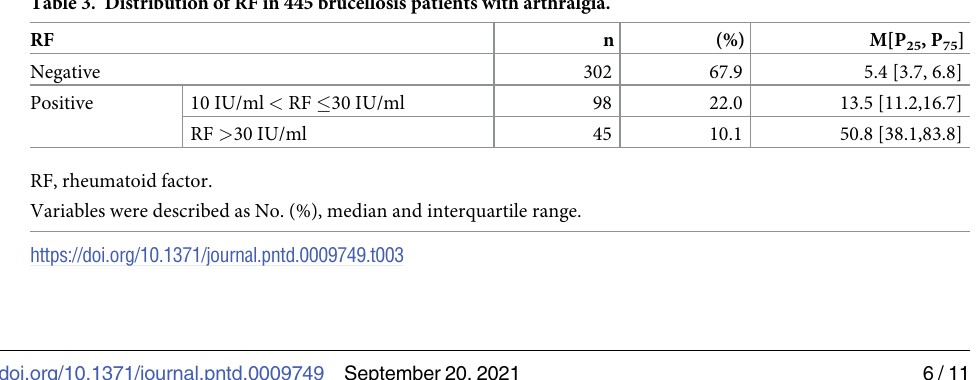
Table 3. Distribution of RF in 445 brucellosis patients with arthralgia. RF